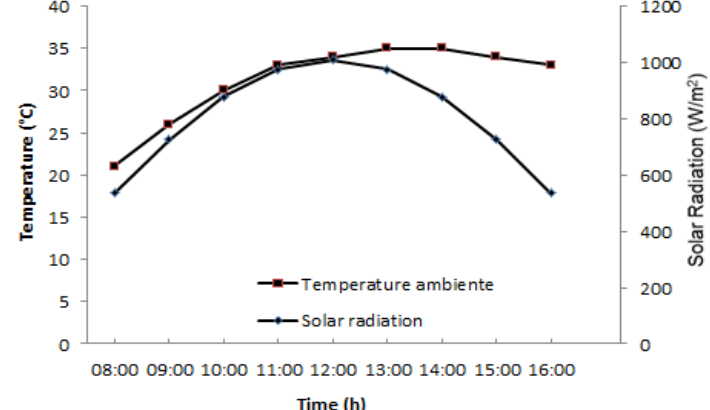
Figure 2. Evolution of solar radiation and ambient